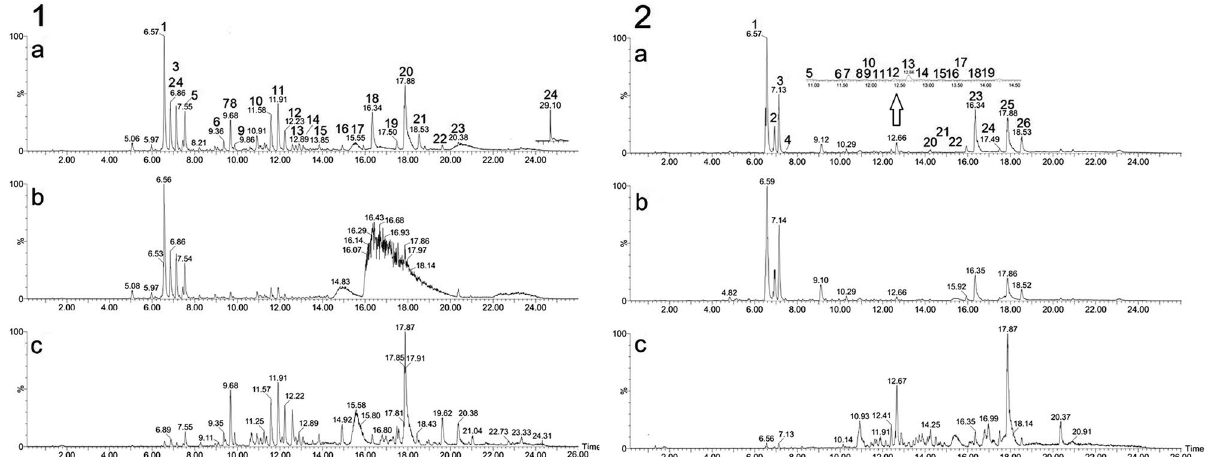
Figure 7. UPLC-ESI-QTOF-MS E chromatograms of Azadirachta indica ( 1 ) and Melia azedarach ( 2 ) leaves extracts in negative ionization mode: ( a ) crude ethanol extract; ( b ) methanol fraction; ( c ) ethyl acetate. The numbers on the peaks are referenced in Tables 3 and